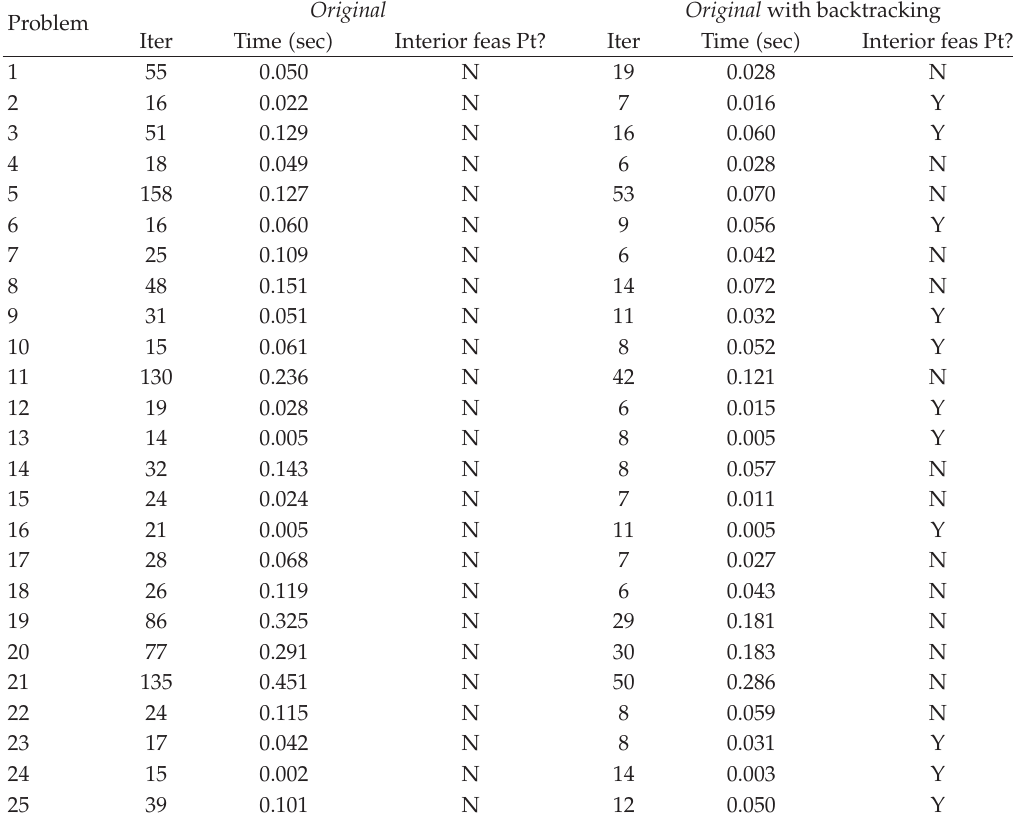
Table 6: CQCs: comparison of the Original method and Original method with